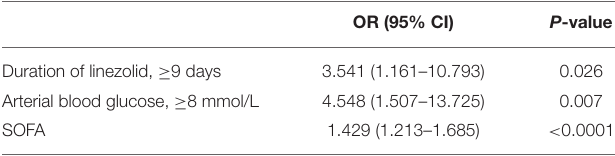
FIGURE 3 | Receiver operating characteristic curve analysis was used to evaluate the accuracy of the risk prediction model. Area under the curve was 0.849 with 95% CI (0.772–0.926) ( p < 0.0001). Cutoff was 0.2825 with a sensitivity of 91.4%, a specificity of 65.1%, a negative predictive value of 93.2%, and a positive predictive value of